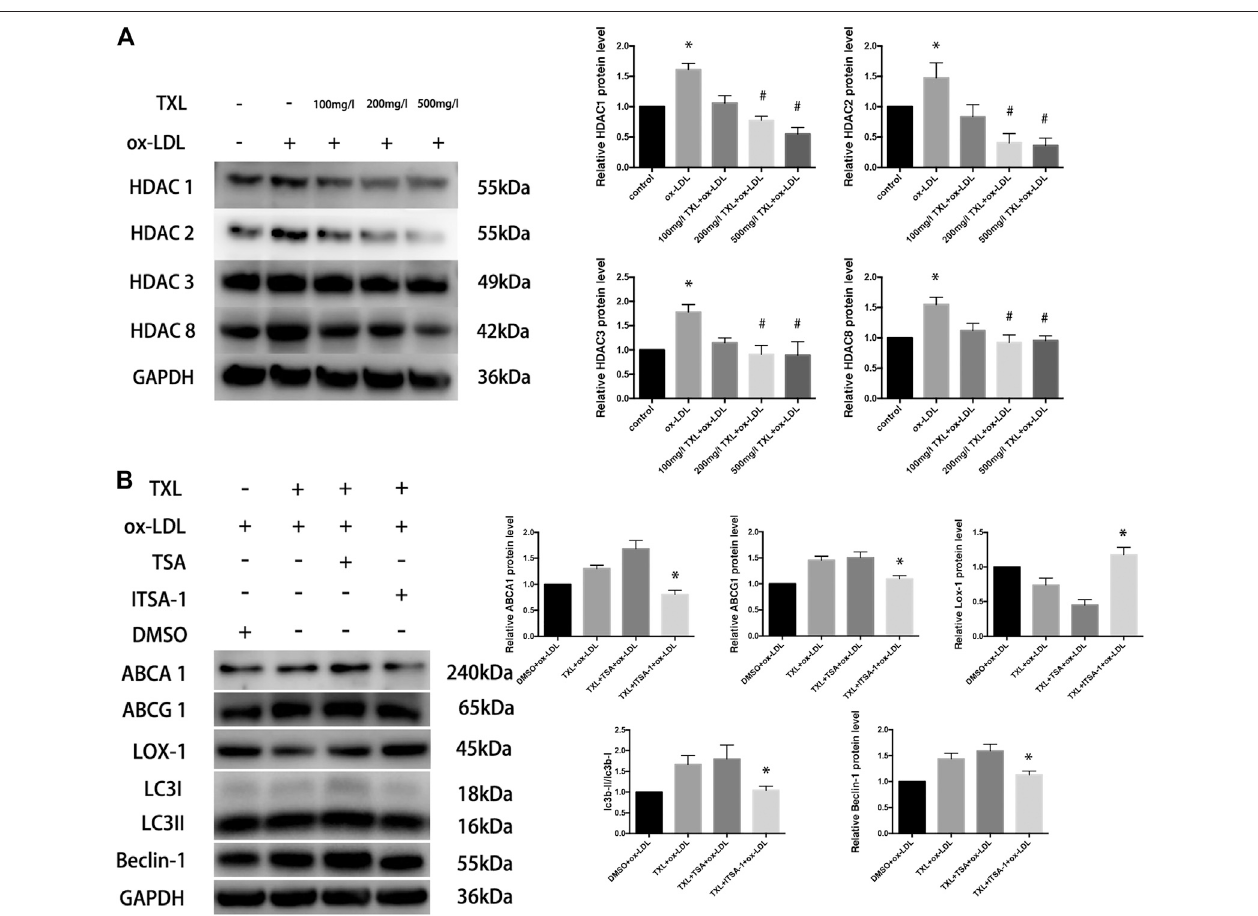
FIGURE 4 | TXL increase macrophage autophagy through histone deacetylase inhibition. (A) Western blot revealed the effect of TXL on ox-LDL-induced macrophagetypeIhistonedeacetylaseexpression, n (cid:2) 5,* p < 0.05vs.control, # p < 0.05vs.ox-LDL. (B) Westernblotrevealedhistonedeacetylaseinhibitedtheeffectof TXL on macrophage lipid deposition, n (cid:2) 5, * p < 0.05 vs. TXL + ox-LDL.